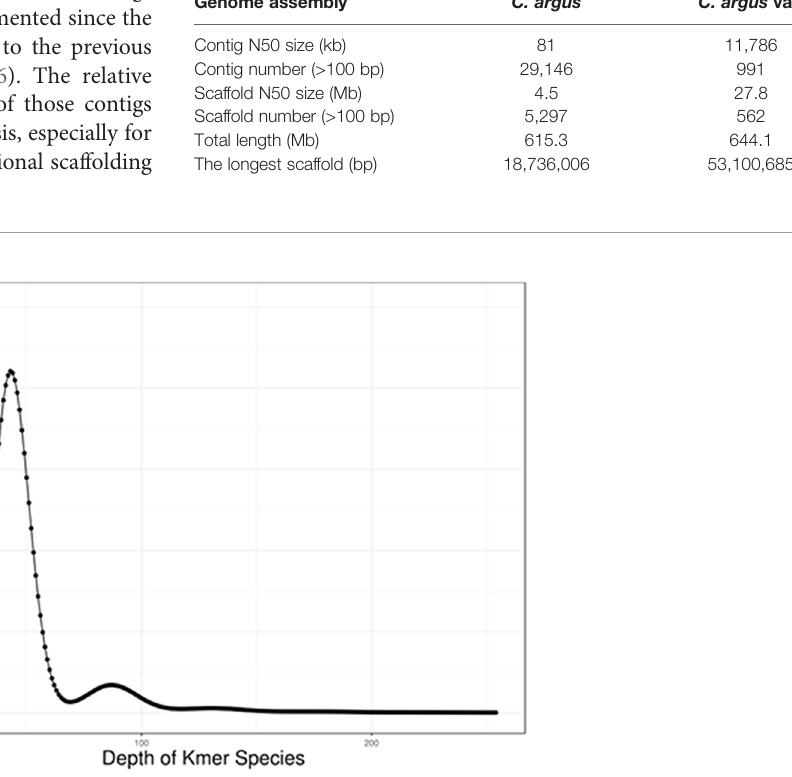
TABLE 3 | Comparison of the two versions of genome assembly based on the short- and long-read sequencing technology, respectively. Genome assembly